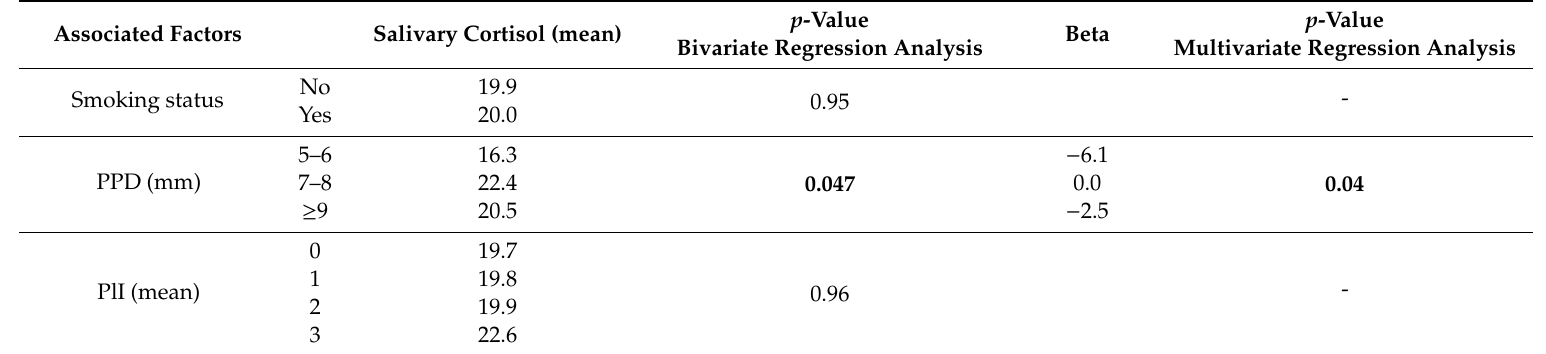
Table 3. Associated factors with high levels of salivary cortisol in pathological sites from diseased